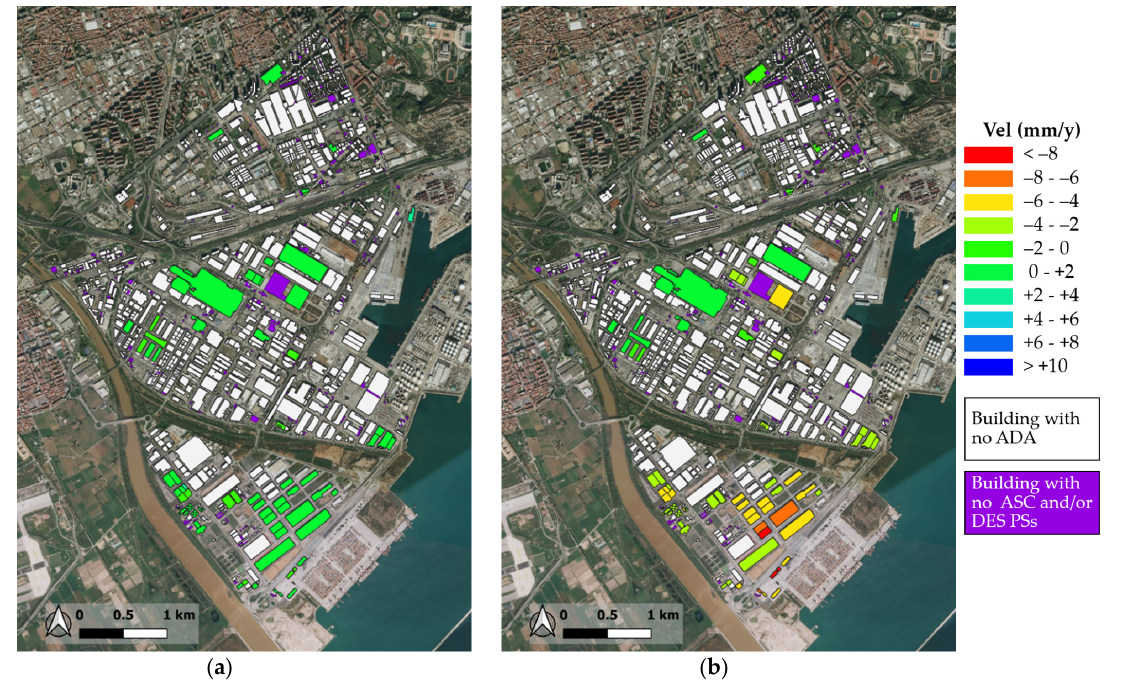
Figure 9. Maps of ( a ) V EW and ( b ) V V components for the “unstable” buildings in Zona Franca area. The violet polygons represent buildings with original lack of PSs.